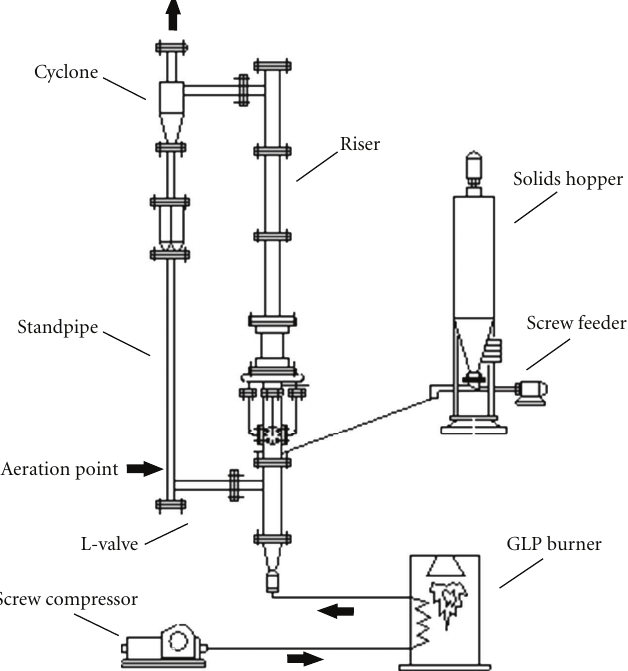
Figure 1: Experimental assembly setup, adapted from Behainne